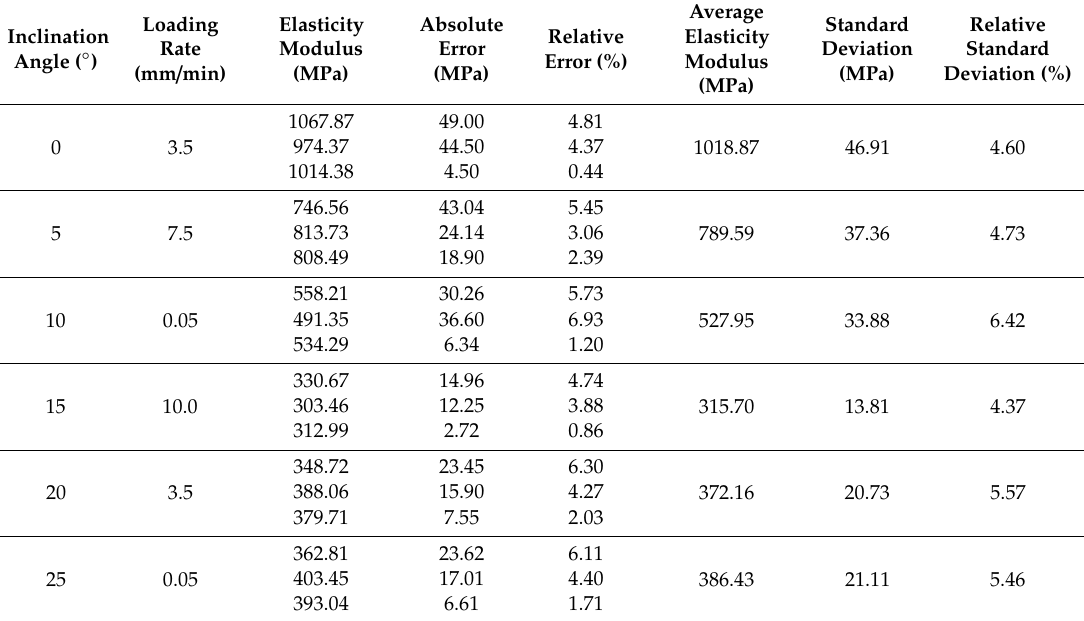
Figure 10. Elastic modulus varies with the loading rate and inclination angle: ( a ) Relationship between elastic modulus and inclination angle; ( b ) relationship between elastic modulus and loading rate. Table 3. Elastic modulus under various loading rates and inclination angles.